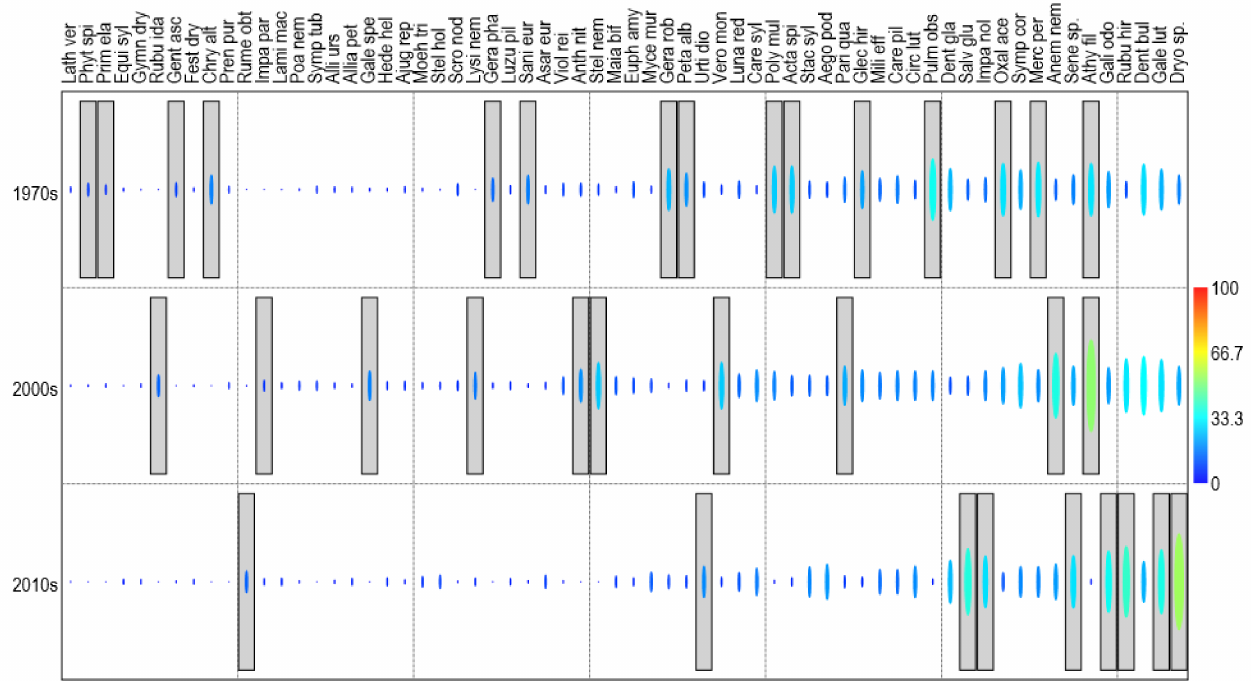
Figure 4. Results of indicator species analysis. Values of indicator value of species (IndVal%) for study periods are presented. The statistical significances ( p < 0.05) of the indicator values have been boxed.